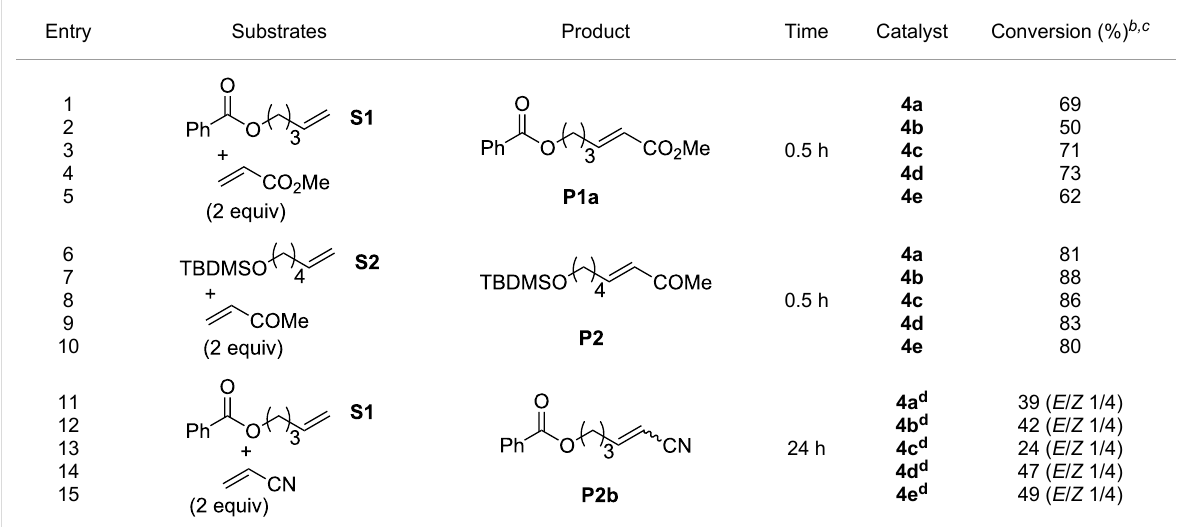
Table 1: Scope of 4a – e for CM transformations a .